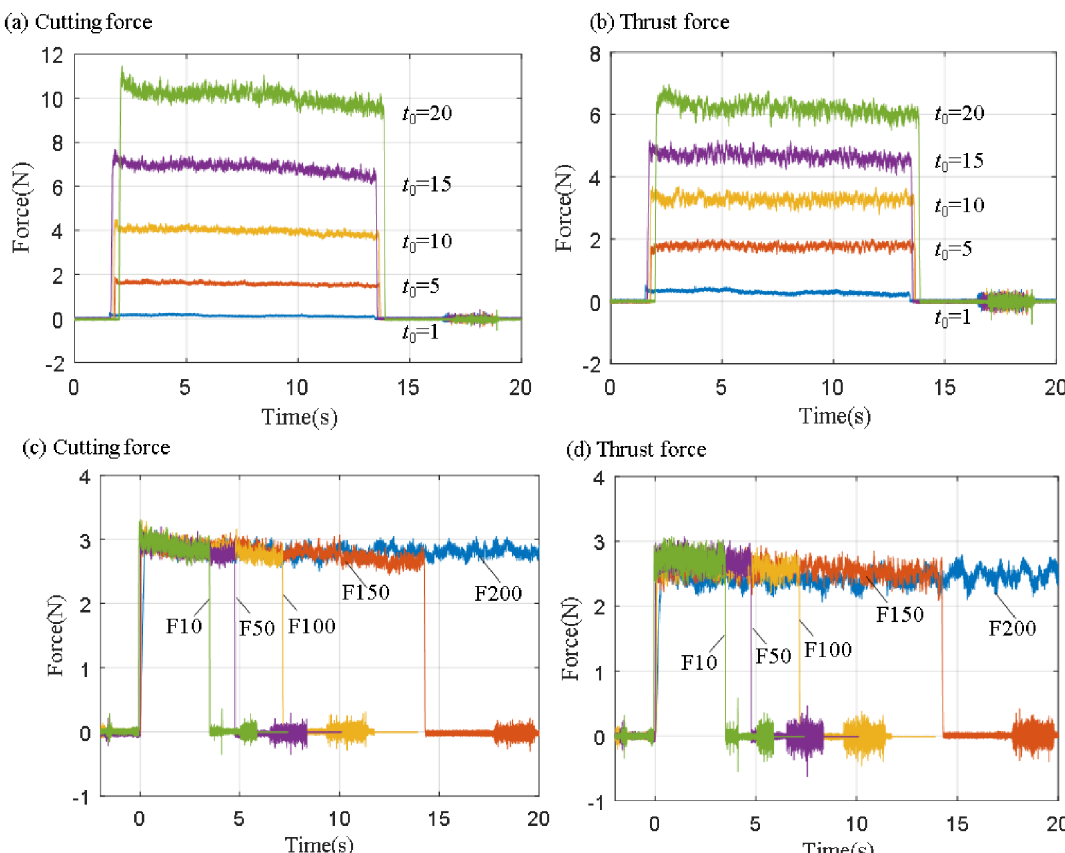
Figure 4. Dynamic cutting force curve. ( a , b ) the cutting speed was 60 mm/s, with different depths of cut; ( c , d ) the depth of cut was 8 µ m, with different cutting